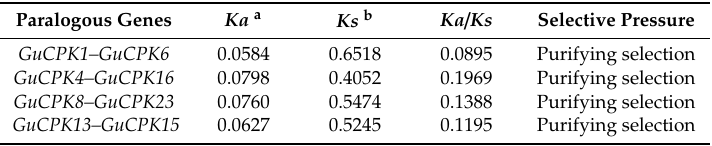
Figure 5. Segmental duplication of GuCPK genes and syntenic analysis of G. uralensis , G. max, and Arabidopsis CPK genes. Chromosomes and scaffolds were shown in different colors with circular form. The positions of the CPK genes were marked with black lines on the circle. The duplicated CPK pairs in G. uralensis were linked by red lines, syntenic relationships between G. uralensis and the other two species were linked by purple lines, and blue lines indicated the CPK pairs between or inside G. max and Arabidopsis . Table 1. The Ka / Ks ratios for duplicate CPK genes in G. uralensis .